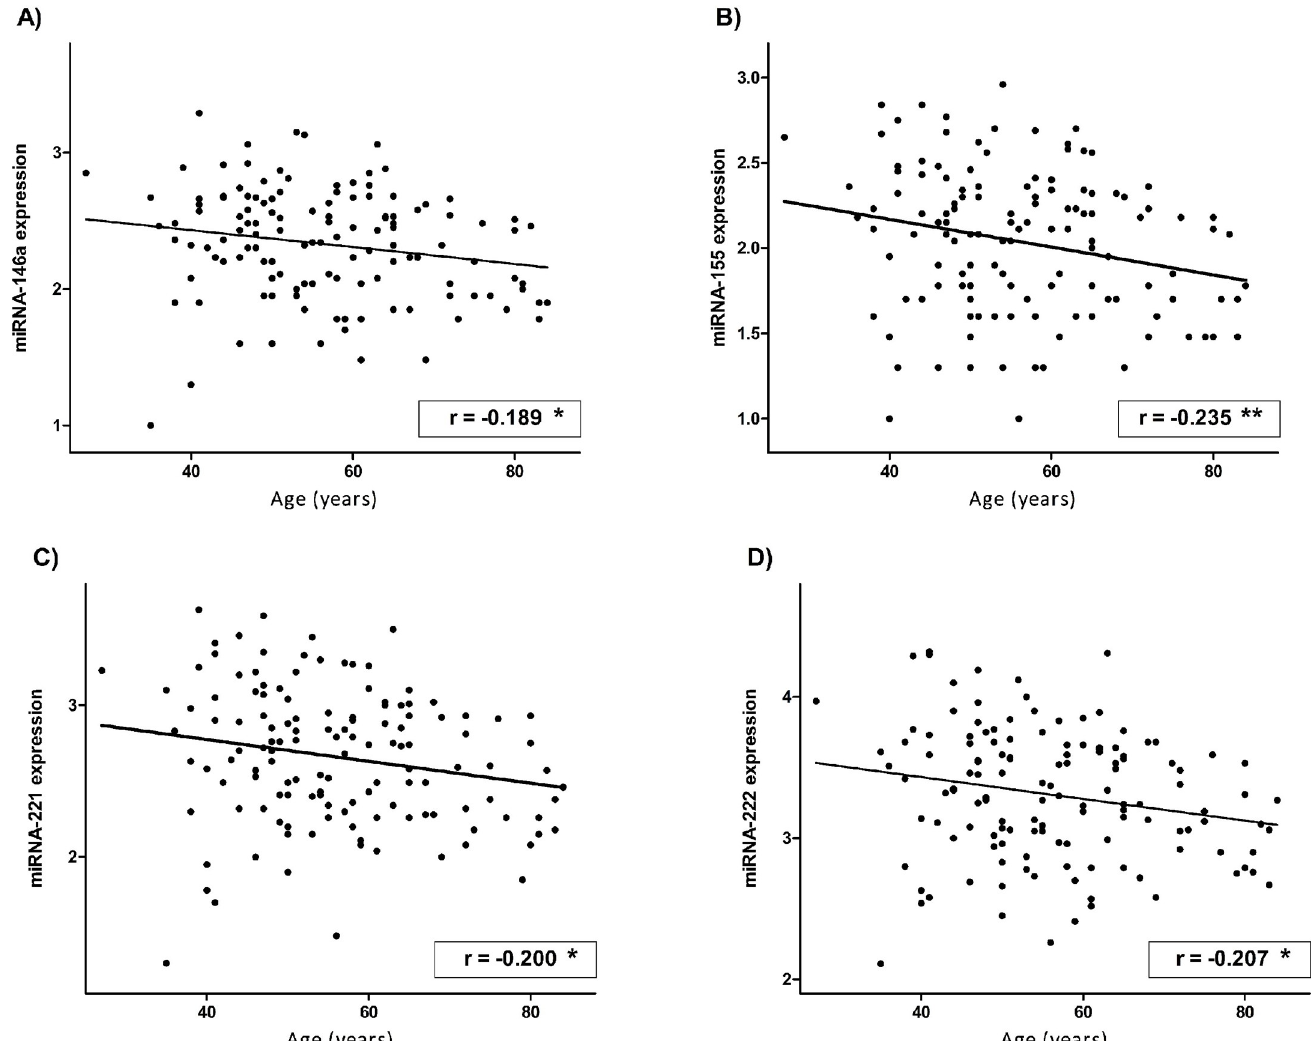
Fig 2. Correlations of the expression of miRNA-146a (A), -155 (B), -221 (C) and -222 (D) in blood of BC patients with age at diagnose at pre-RT control. miRNA expression was calculated as log(2 -DCt )+3. Pearson correlation coefficient (r) is shown. -means inverse correlation. � means significant differences at p < 0.05 (bilateral). �� means significant differences at p < 0.01